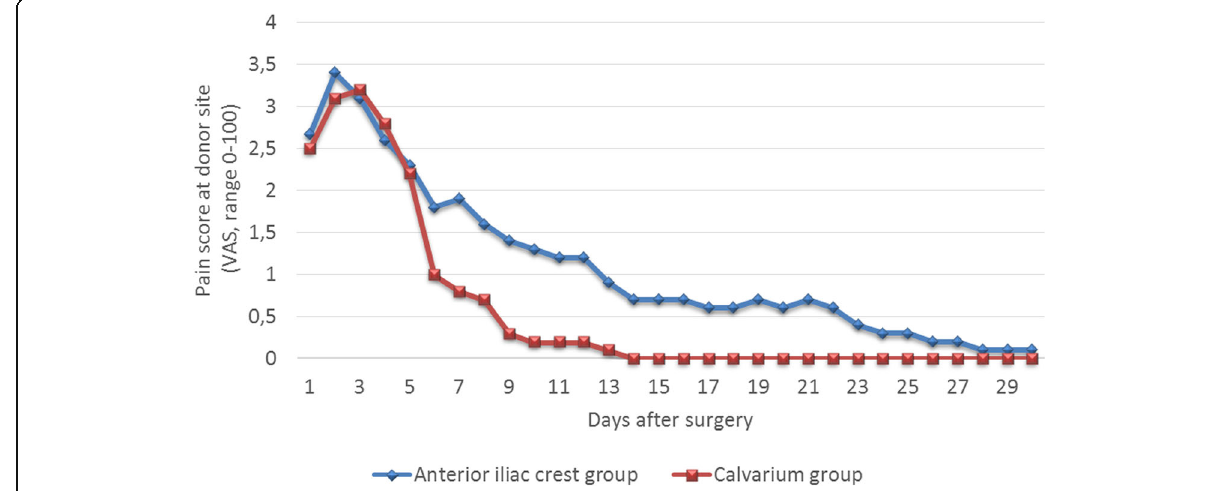
Fig. 2 Significant difference between groups in mean post-operative pain at donor site. During the first 30 days following maxillary reconstruction with either calvarial ( n = 10) or anterior iliac crest ( n = 10) bone grafts, participants scored the pain felt at donor site using a 100- mm VAS scale ( ‘ 0 ’ represents ‘ no pain ’ and ‘ 100 ’ represents ‘ worst pain ever ’ ). The mean VAS scores for pain ranged from 32.5 ± 17.1 (day 2) to 3.5 ± 15.8 mm (day 14). A linear mixed model determined a significant difference between treatment groups with an estimated effect of 0.09 (standard error = 0.015) for the anterior iliac crest group ( G = 31.3, p = 0.00), meaning the pain scores of anterior iliac crest group are higher than the calvarium group scores ( F = 31.30, p <